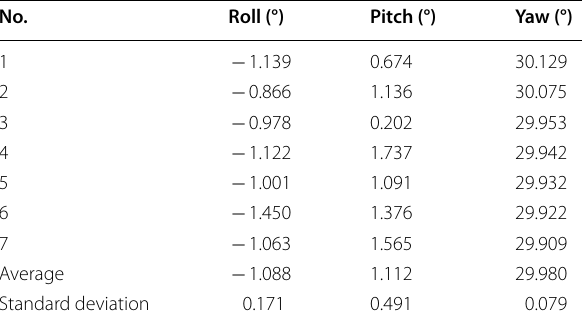
Table 1 Calculated results of the comparative attitude angle observation